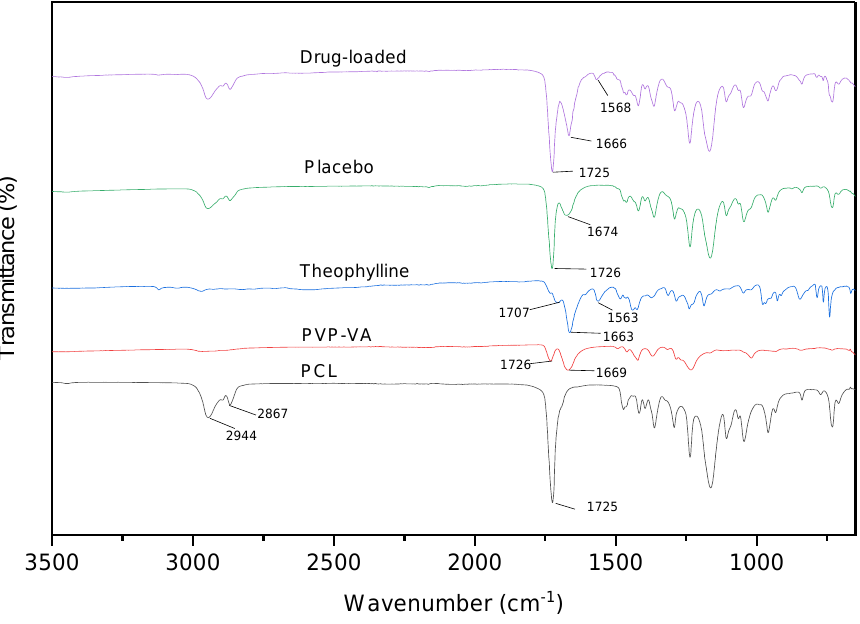
Figure 7. FTIR spectra of the neat material, placebo, and drug-loaded blends. The thermal stability and crystal structure of the materials were analyzed using DSC.